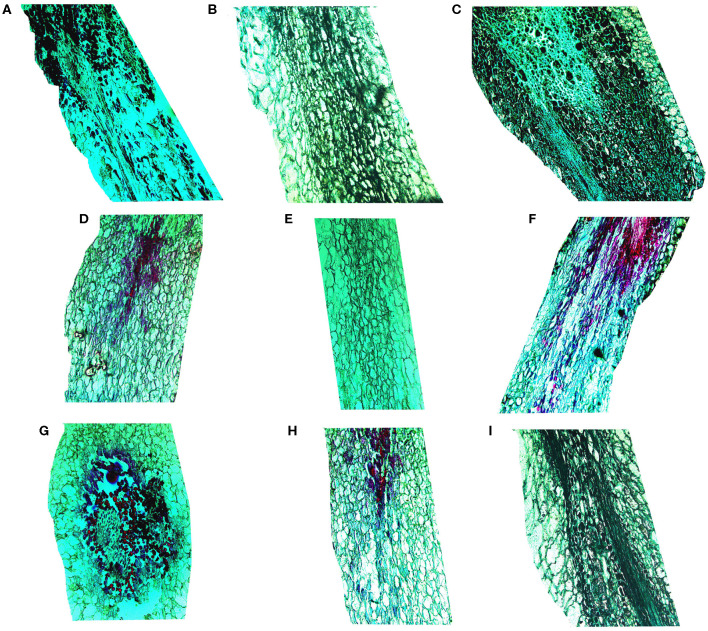
The microstructure of berry brush cells of table grapes stored for 0, 3, or 6 days (×50). After storage for 0 day in “Muscat Kyoho” (A), “Kyoho” (B), and “Nanyu” (C); after storage for 3 days in “Muscat Kyoho” (D), “Kyoho” (E), and “Nanyu” (F); after storage for 6 days in “Muscat Kyoho” (G), “Kyoho” (H), and “Nanyu” (I). All images are of transverse sections.